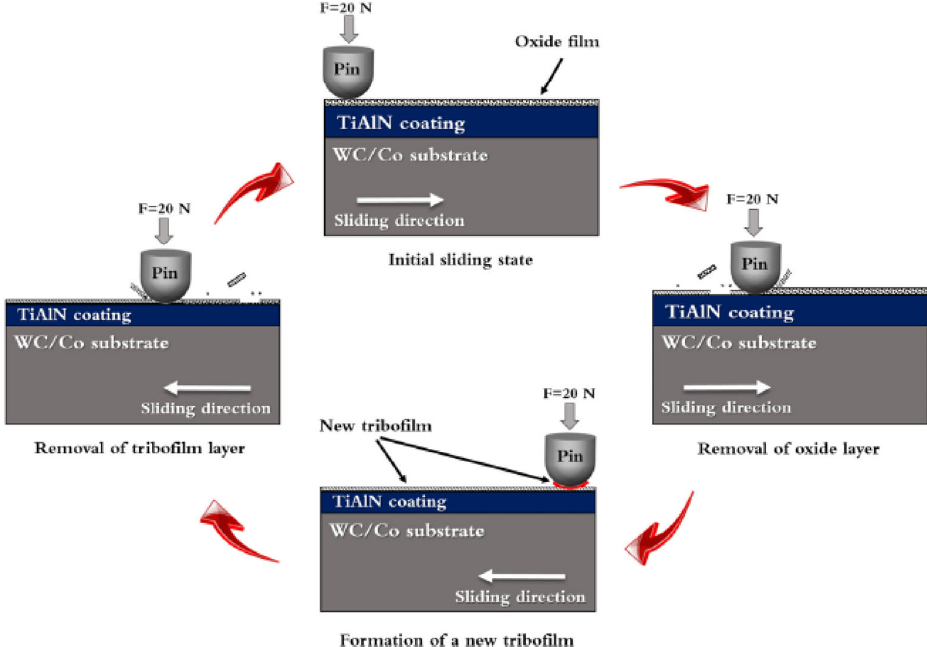
Fig. 42 Schematic illustration of tribo-chemical wear mechanism of TiAlN coating tested against 316L stainless steel at 800 °C [787]. Reproduced with permission from Ref. [787], © Elsevier Ltd.,